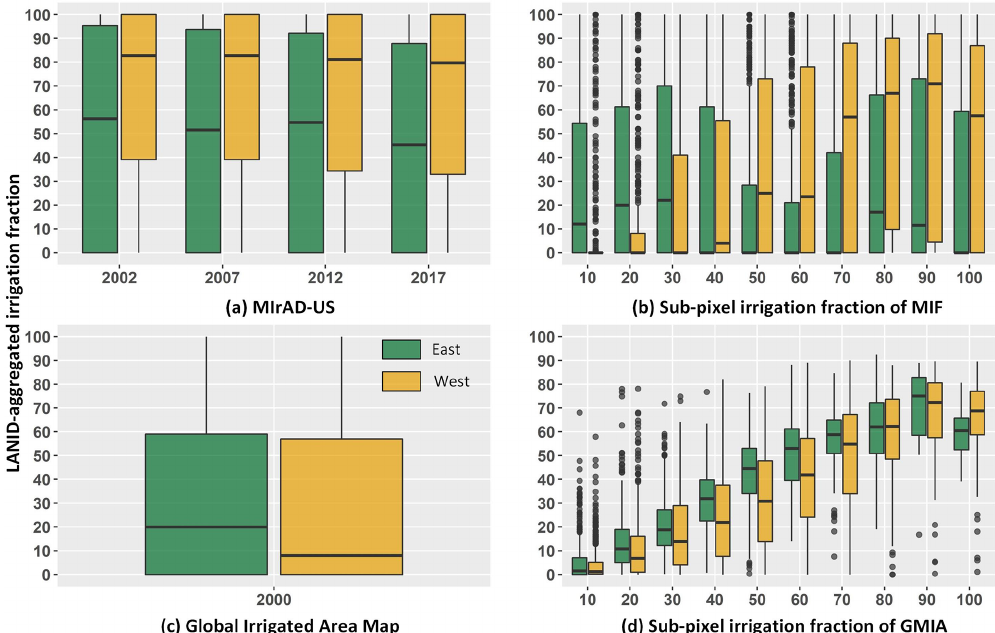
Figure 15. Box plots showing irrigation fraction mapped in each product using LANID as reference. The western and eastern CONUS (separated by red line in Fig. 2) are shown as brown and green, respectively. The 30m LANID maps were aggregated as an irrigation fraction to match the spatial resolution of each product (e.g., 250m for MIrAD). For binary maps MIrAD and GIAM, 5000 irrigated samples were stratified for both west and east; 50 samples were selected for each irrigation fraction from 1% to 100% (with increments of 1%) in MIF and GMIA. The numbers on the horizontal axes of (b) and (d) refer to the maximum value of each